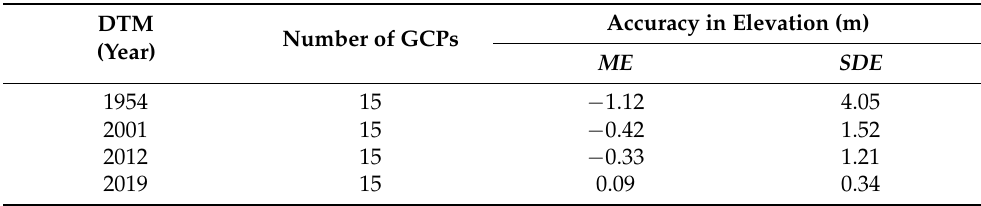
Table 3. Accuracy of digital elevation models (DEMs), assessed by independent ground control points (GCPs) and expressed in terms of mean error ( ME ) and standard deviation error ( SDE